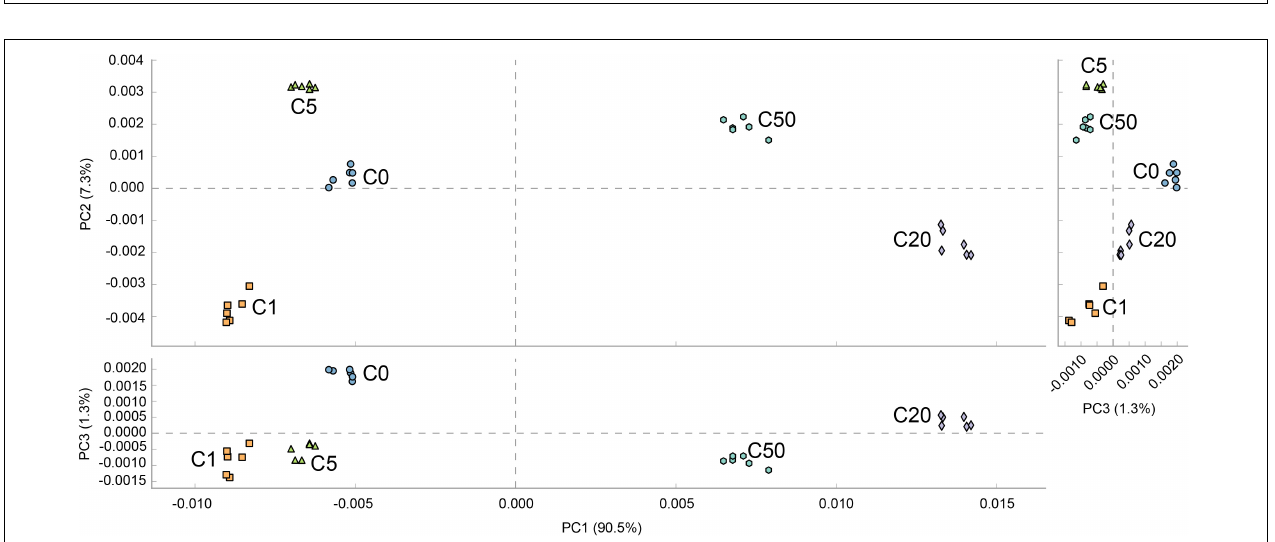
FIGURE 7 | PCA profile based on metabolic characteristics of Xenopus laevis gut microbiota treated with different MC-LR concentrations. Numbers after the letter C in the group names indicate MC-LR concentrations.